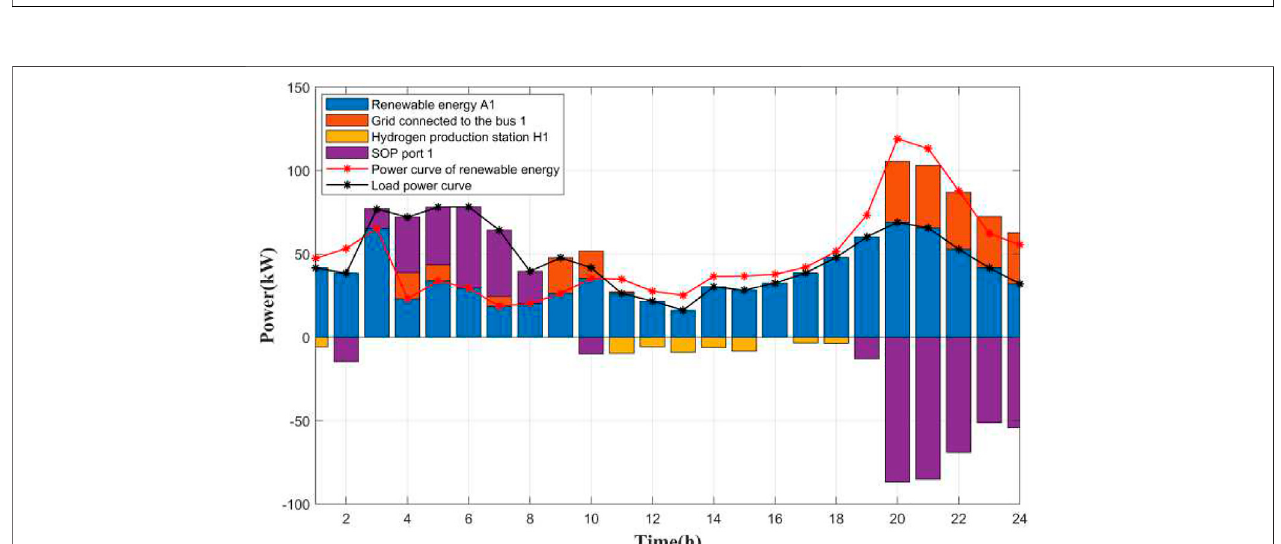
FIGURE 10 | Operation of bus 1.